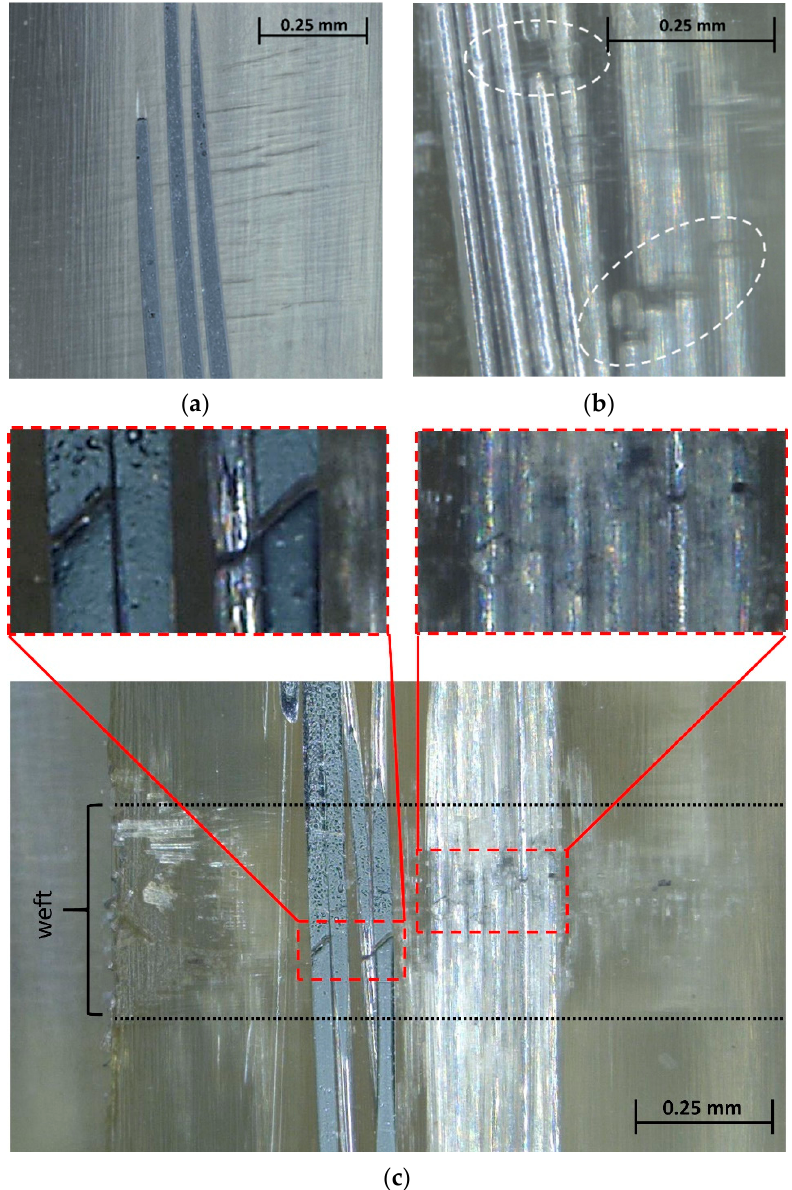
Figure 19. Post-rupture (offline) micrographs of the polished specimens showing inter fiber cracks ( a ) and internal aluminum fiber ruptures ( b , c ).